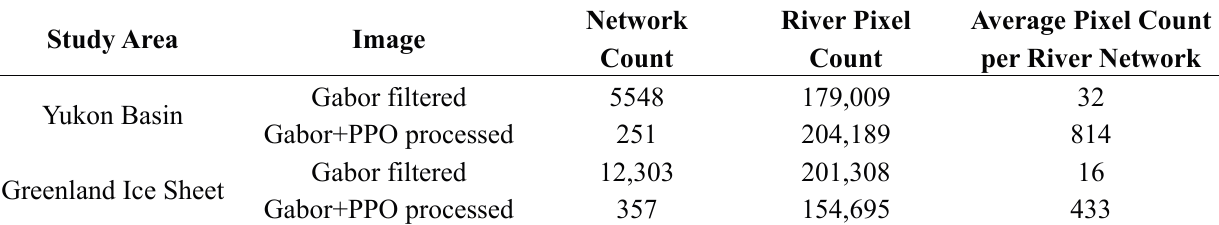
Figure 13. River network labeling results for ( a ) the Gabor filtered Yukon image; ( b ) the Gabor filtered GrIS image; ( c ) the Gabor-PPO processed Yukon image; and ( d ) the Gabor-PPO processed GrIS image. The river networks obtained from the Gabor filtered images are very fragmented, while those from the Gabor-PPO processed images are much more continuous, indicating that the proposed method can preserve the river network continuity very well. Table 3. Summary statistics of the network count, the river pixel count, and the average pixel count per river network for the Gabor filtered and the Gabor-PPO processed images in the two study